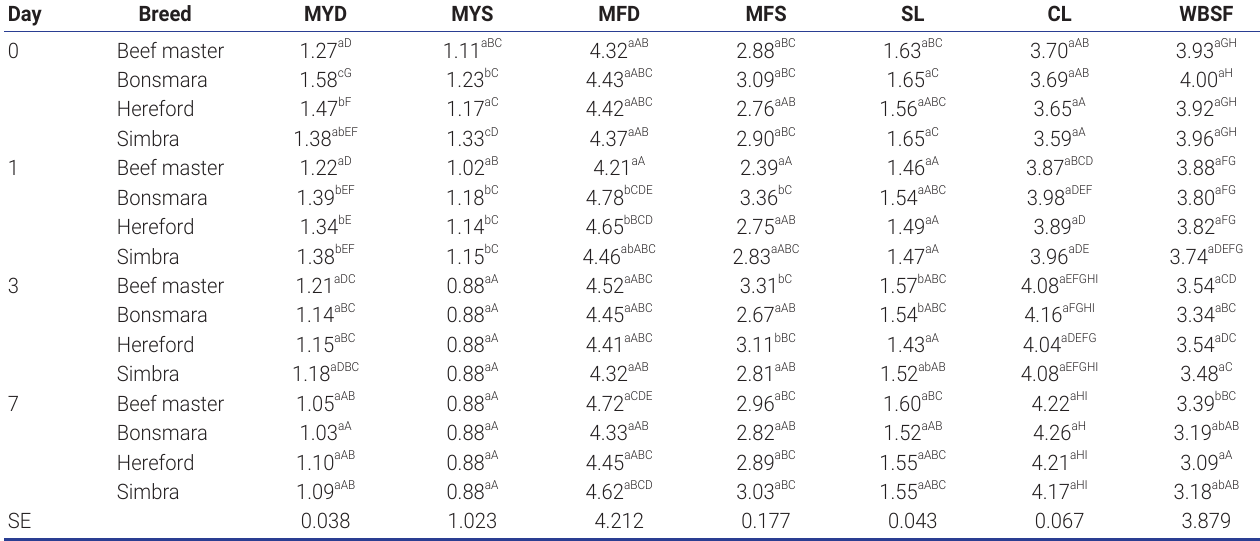
Table 1. Muscle nanostructure, tenderness and cooking loss of South African A2 beef breeds during 7 days of ageing at –20°C Day